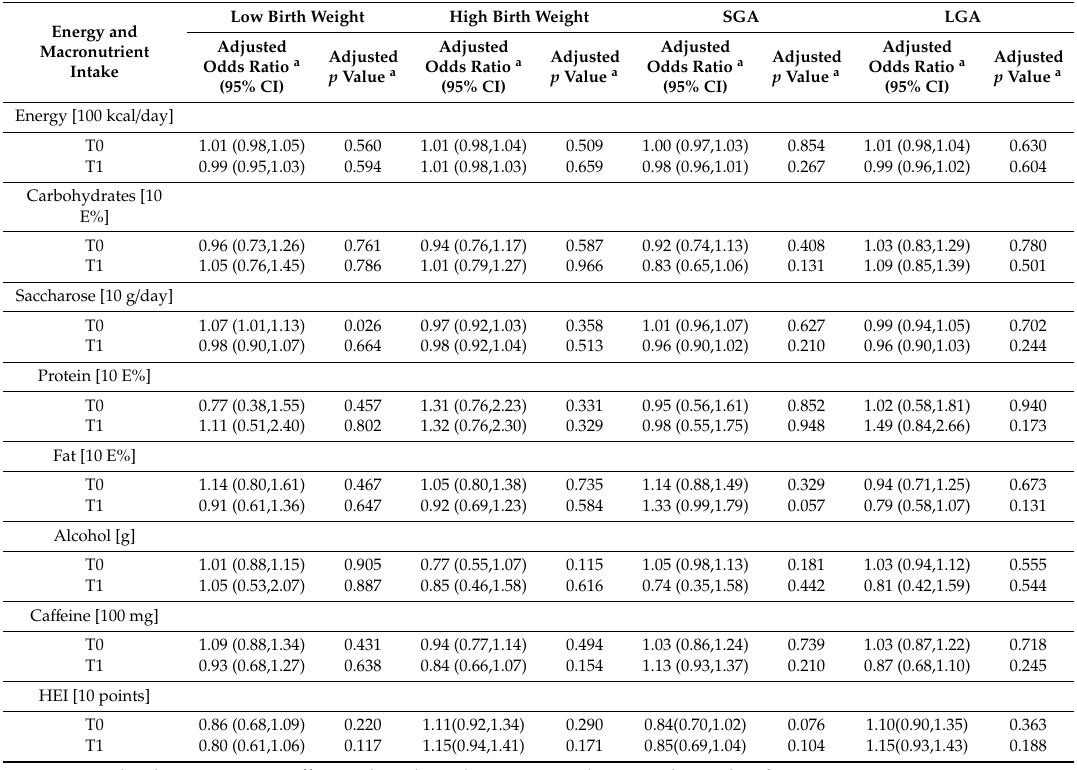
Table 5. Associations between maternal energy, macronutrient intake and dietary quality and neonatal weight-related